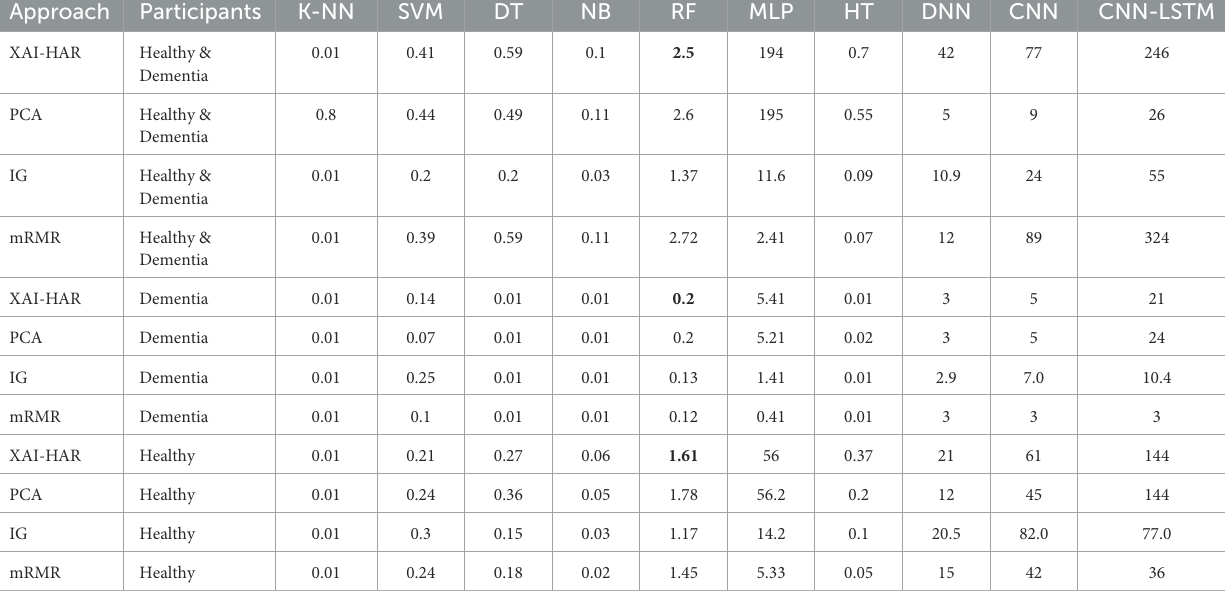
TABLE 4 Time-based comparison of XAI-HAR with other feature selection and classification techniques for activities in the casas dataset (27). Approach